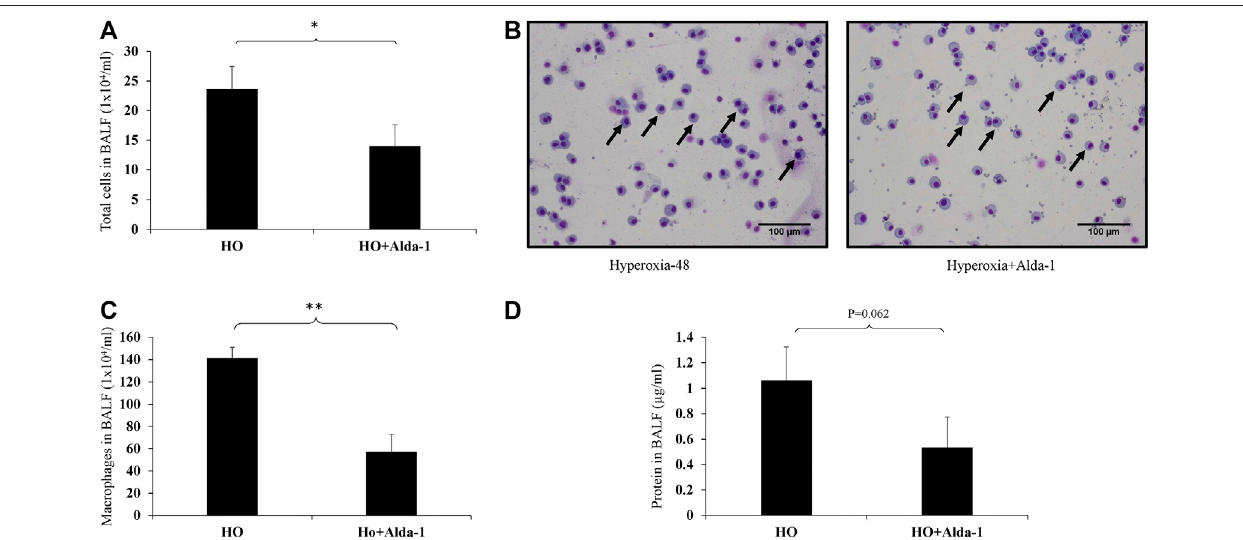
FIGURE 1 | Alda-1 suppresses hyperoxia-induced in fi ltration of immune cells in fi ltration into alveolar space: C57BL/6 mice were divided into three groups: normoxia,hyperoxia,orhyperoxia+Alda-1.MicewerepretreatedwithAlda-1orvehiclefor48 handthendissected.BAL fl uidwascollectedandsubjectedtocellcounts using a hemocytometer or cytospin followed by Diff- Quik staining. (A) Microscopic evaluation of cell totals following cytospin of BAL fl uid collected from normoxia, hyperoxia, and hyperoxia + Alda-1 mice. (B) Diff-Quik staining from normoxia, hyperoxia, and hyperoxia + Alda-1 treated mice (arrow indicates macrophages) (magni fi cation (cid:1)× 200). (C) MicroscopicevaluationofmacrophagenumberinBAL fl uidcollectedfromnormoxia,hyperoxia,and hyperoxia +Alda-1 mice. (D) Analysisof total BAL fl uid protein by BCA assay; representative images are shown from at least three mice/group (* p < 0.05, ** p <